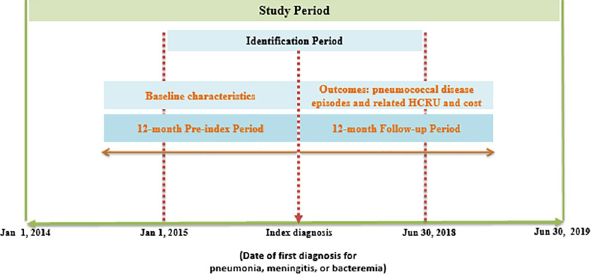
Fig 1. Study periods and timelines. Index diagnosis is defined as the date of first diagnosis for pneumonia. HCRU: healthcare resource